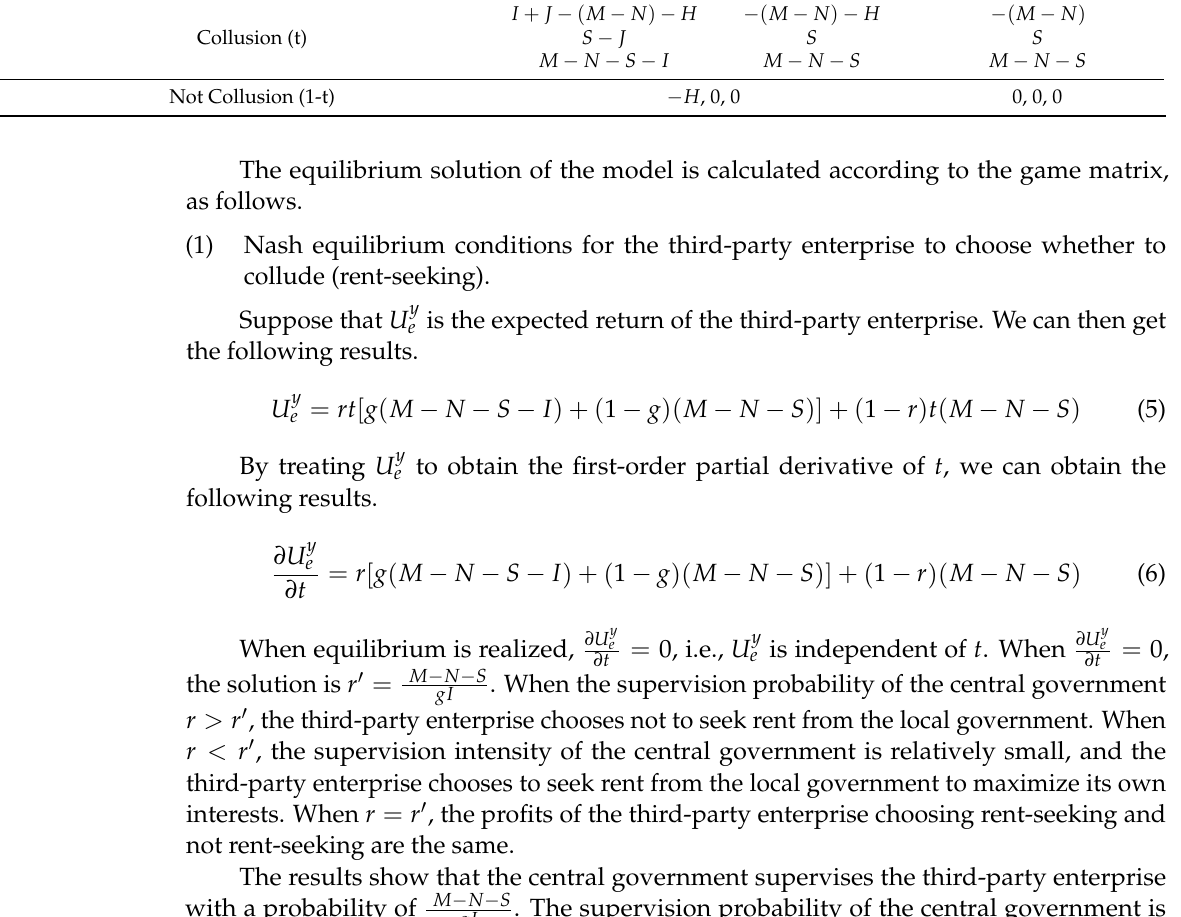
Table 4. The game matrix of the central government, local government, and third-party enterprise. Central Government Supervision Local Government Third-Party Enterprise